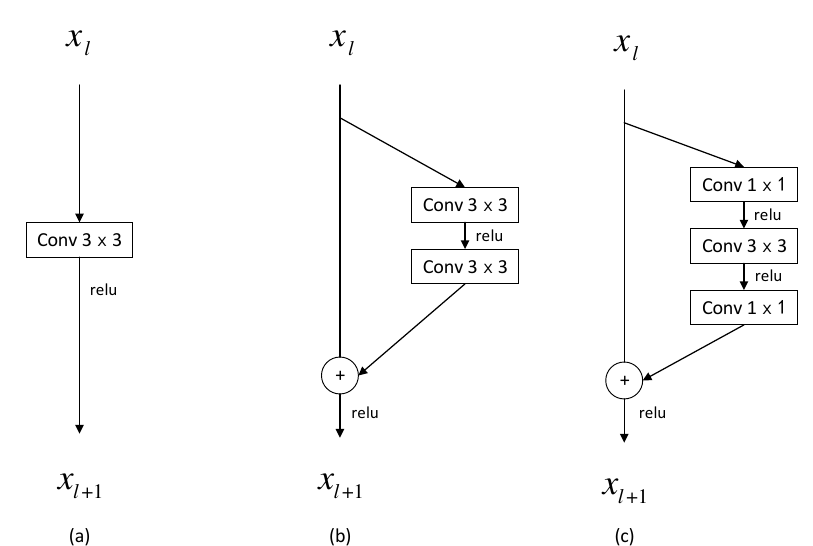
Figure 2. Three variants of the prediction module: ( a ) A 3 × 3 convolutional block; ( b ) A residual block with two 3 × 3 convolutional blocks; ( c ) A residual block with the bottleneck structure.